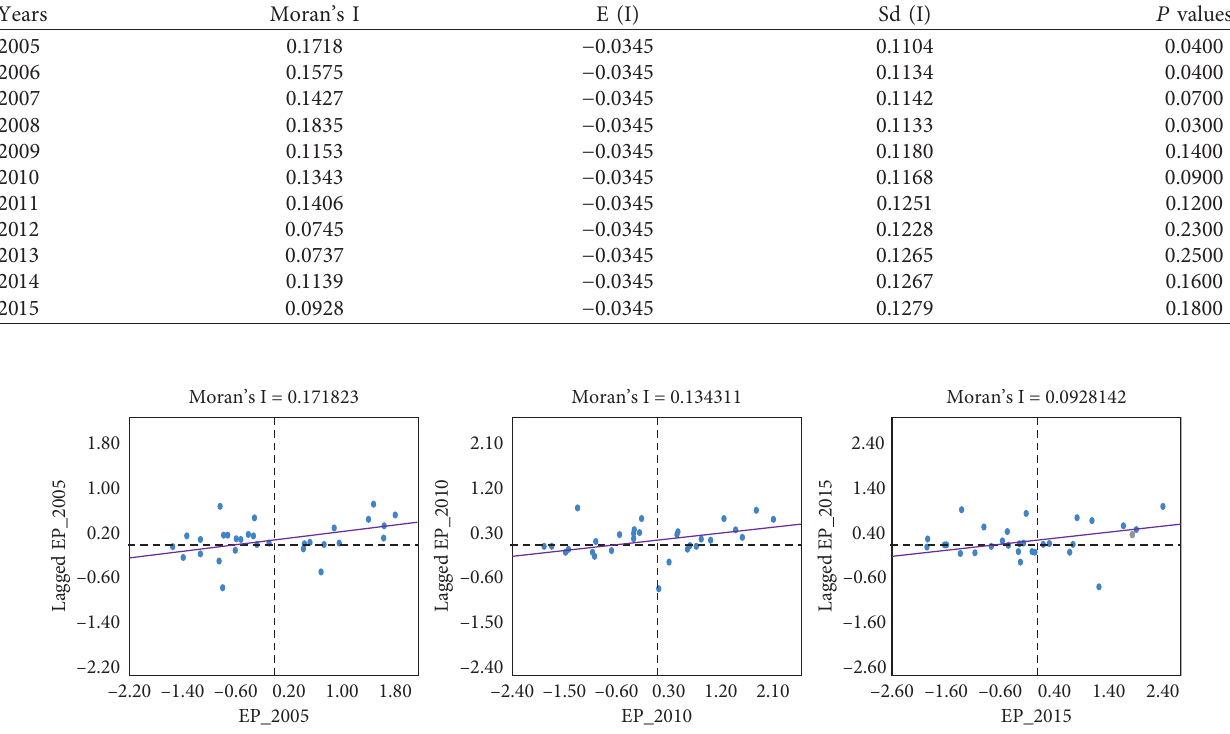
Table 2: Moran’s I values of environmental pollution in China from 2005 to